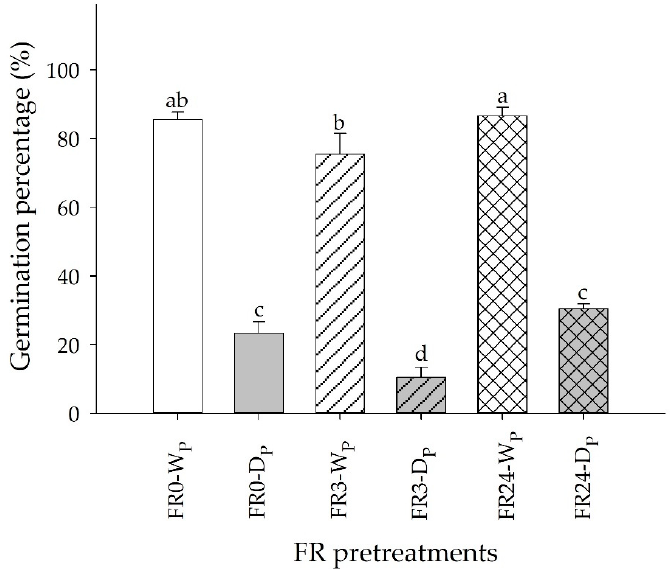
Figure 7. The seed germination response to different FR pretreatment time (0, 3 and 24 h for FR0, FR3 and FR24, respectively) followed by incubation under white light (LED, 400–700 nm, 6500 k, 12-h photoperiod, W) or darkness (D) in a growth chamber. Error bars are the standard error ( n = 6). The same letters indicate no significant difference at p < 0.05 by Fisher’s protected LSD test.